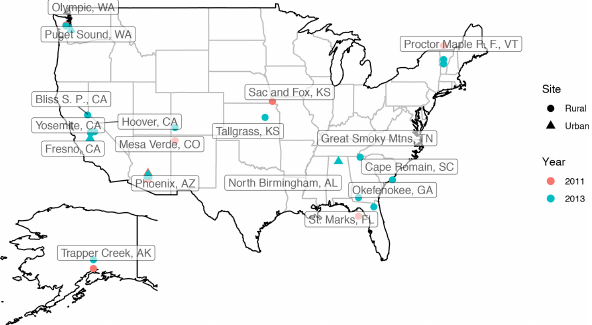
Figure 3. The location of IMPROVE sites used for this work (the US and Alaska); the year in which samples are taken is differenti- ated by color and the type of the site by point shape.